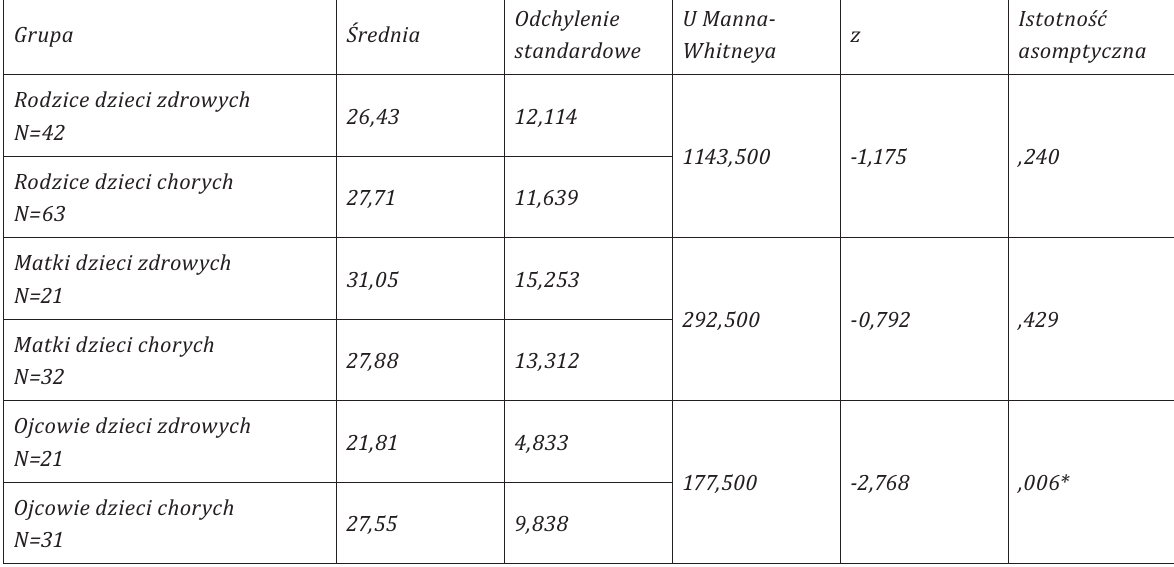
typów spostrzeżeń. Odpowiednie dane zawarte są w Tabeli 1. Tabela 1. Średnia liczba wypowiedzi, odchylenia standardowe i istotności różnic między poszczególnymi grupami